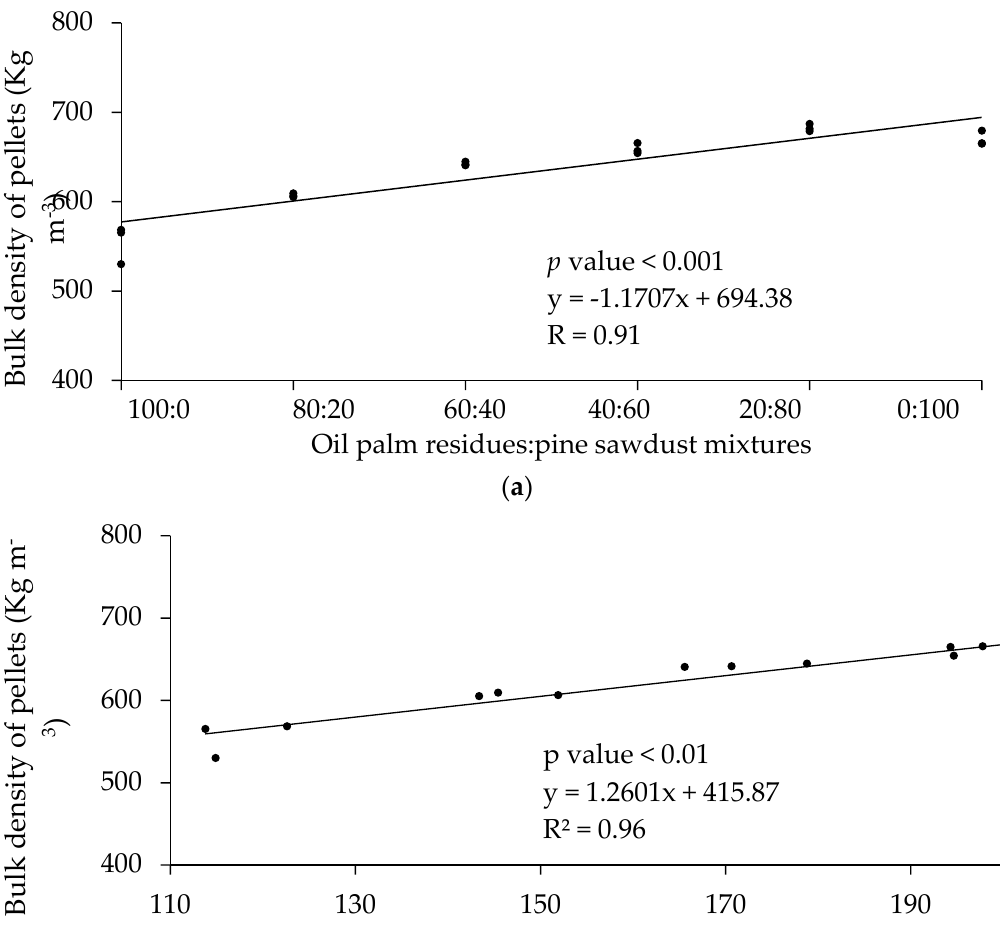
Figure 2. Relationship of bulk density of agro-pellets with: ( a ) mixing ratios of oil palm residues:pine sawdust; ( b ) bulk density of oil palm residues:pine sawdust